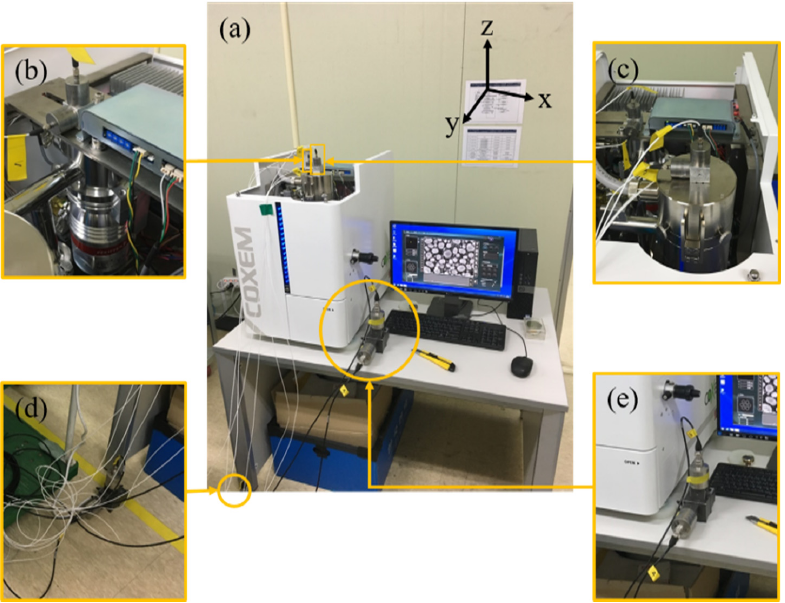
Figure 1. Overall configuration of the EM-30 equipment with accelerometers: ( a ) EM-30 consists of a main body, a computer for data acquisition and signal processing, and a table supporting the equipment; accelerometers were installed on ( b ) the pump with directions along the y- and z- axes, ( c ) electron gun with directions along the x- and z- axes, ( d ) floor (ground) with directions along the y- and z- axes, and ( e ) table with directions along the y- and z- axes.